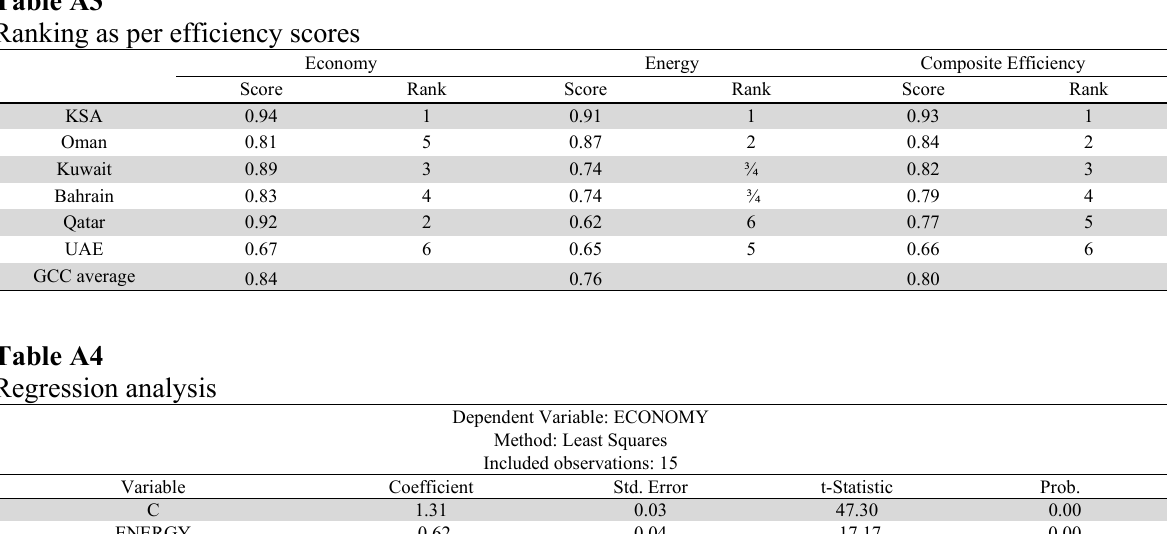
Ranking as per efficiency scores